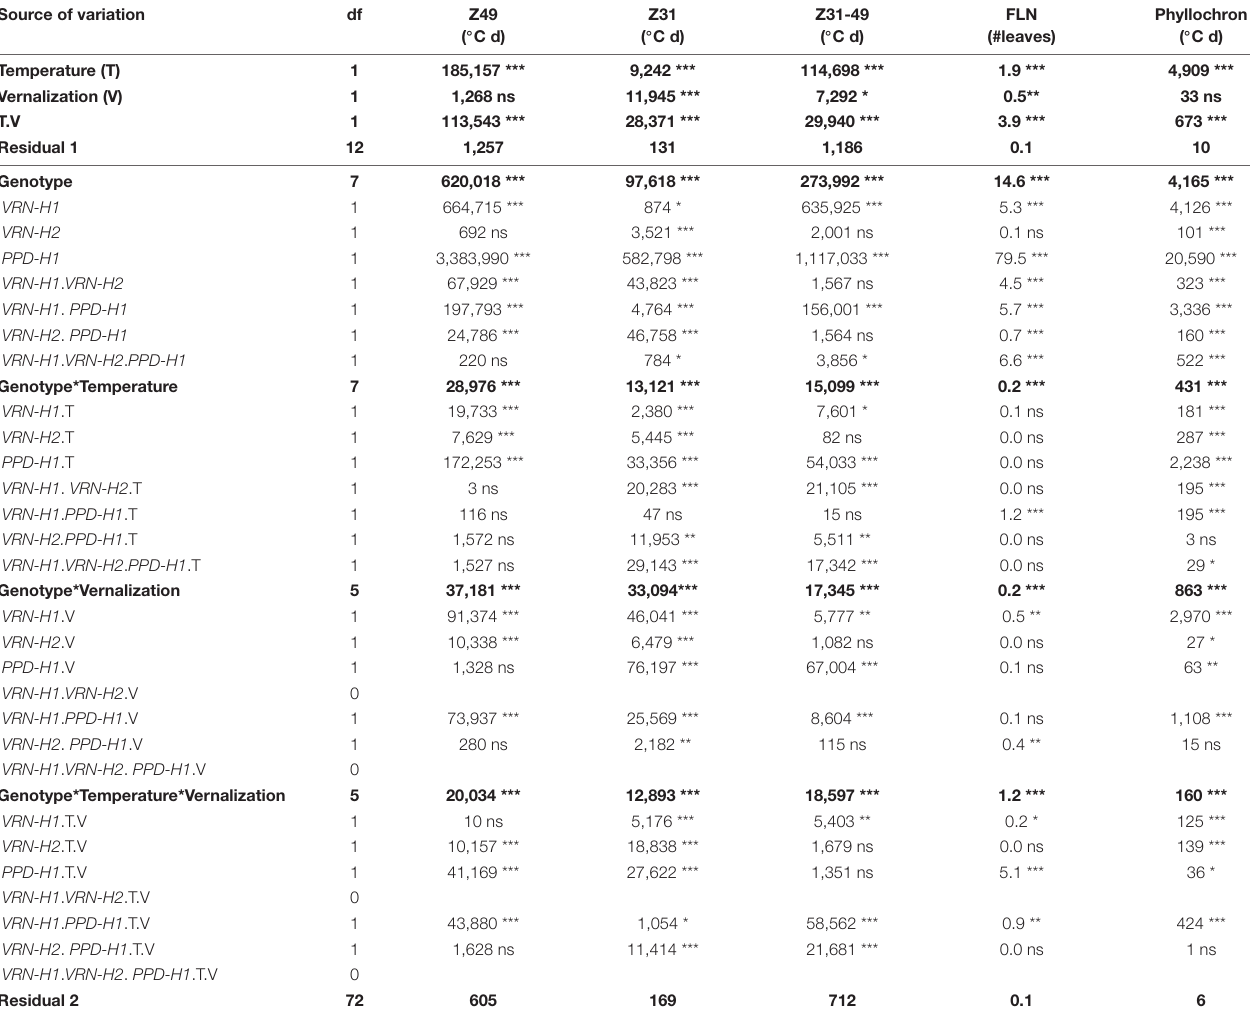
TABLE 2 | Mean squares from the analyses of variance for the main developmental traits, considering only the eight NILs. Source of